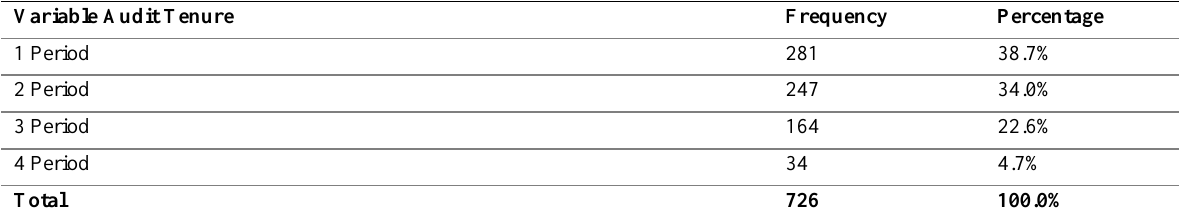
Table 2: Descriptive Analysis of Tenure Audit